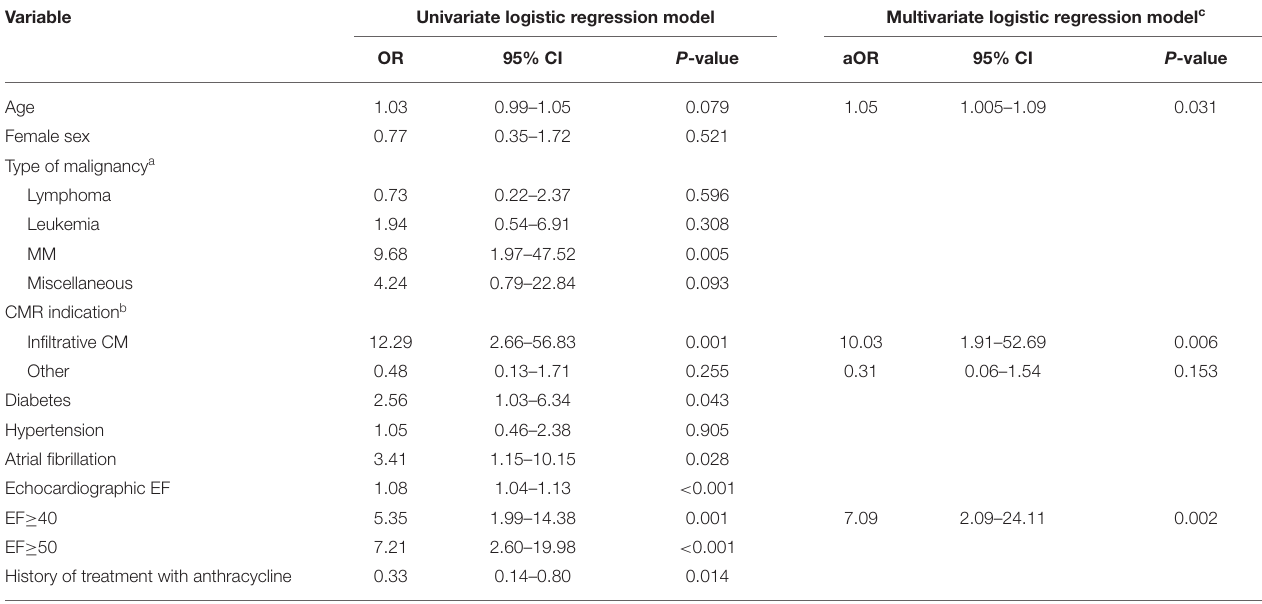
TABLE 6 | Selected univariate and multivariate analysis of factors predicting diagnosis change following CMR. Variable